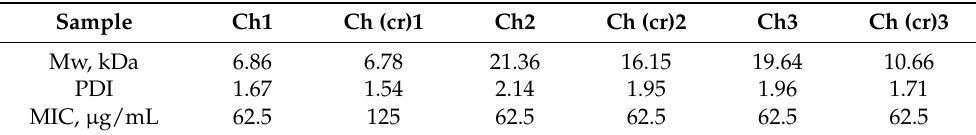
Table 2. The antibacterial activities of crab and insect chitosan samples against S. epidermidis . Ch—insect chitosan; Ch (cr)—crab